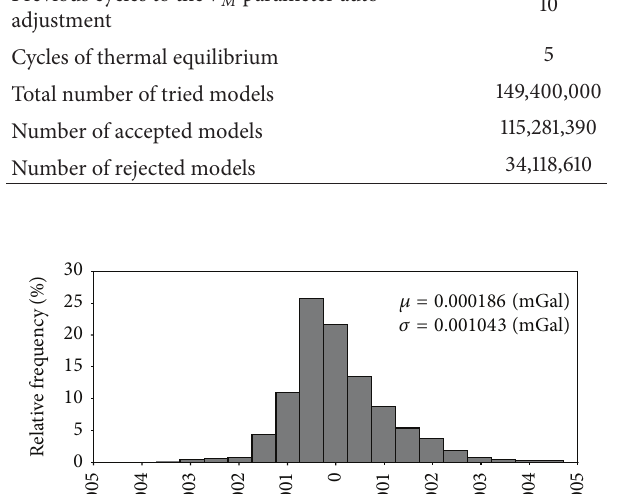
Figure 15: Temperature versus energy curve in the 3D gravity inversion